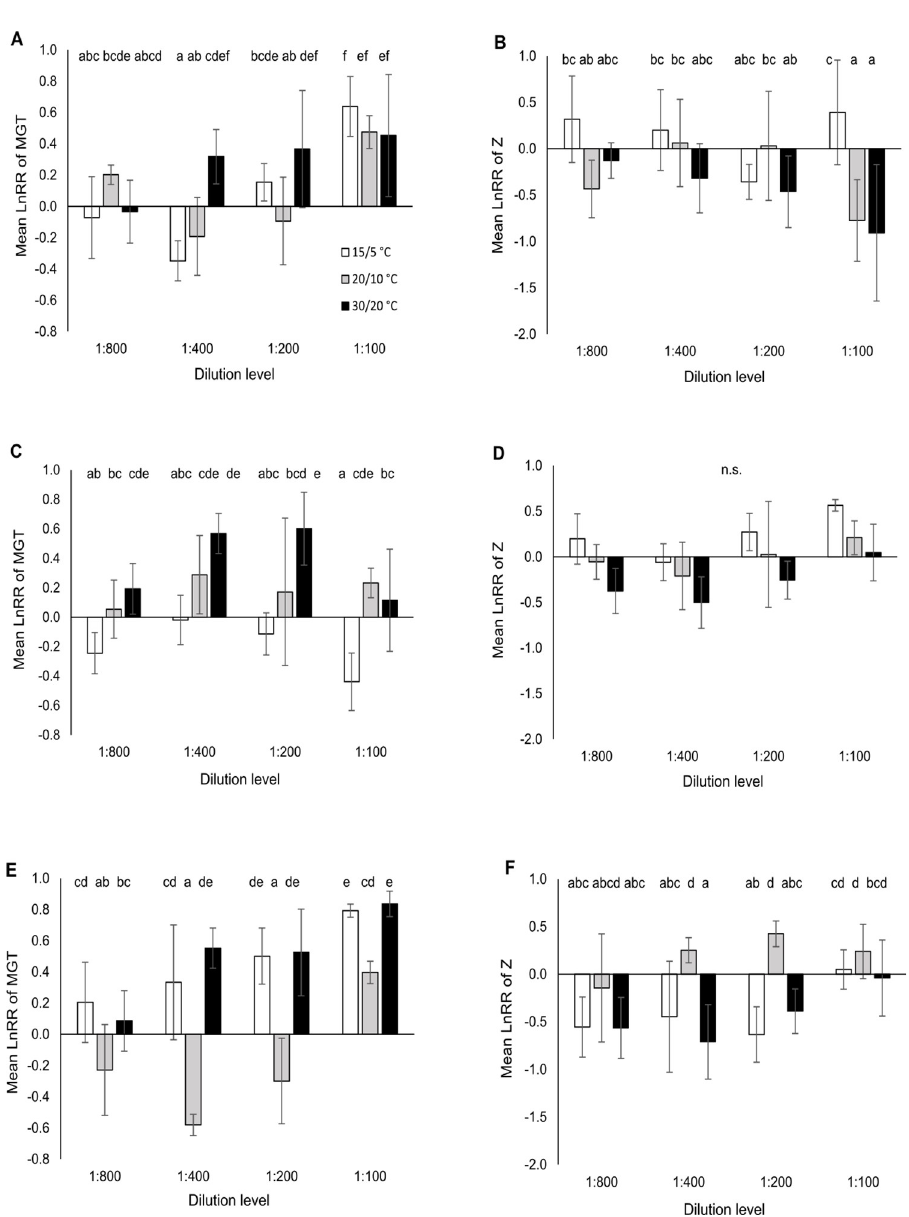
Fig 3. Mean ( ± 95% confidence intervals) natural-logarithm response ratio (LnRR) of the timing variables: Mean germination time (MGT) and synchrony of germination (Z) for a dilution series of the anthelmintic formulation Cydectin (moxidectin 0.1%) for three different temperature regimes and three test species (A,B: Centaurea jacea , C,D: Galium mollugo , E,F: Plantago lanceolata ). Effect of formulation was considered significant when the 95% confidence interval did not overlap with zero. Different letters indicate significant differences between treatments (p < 0.05; Tukey HSD